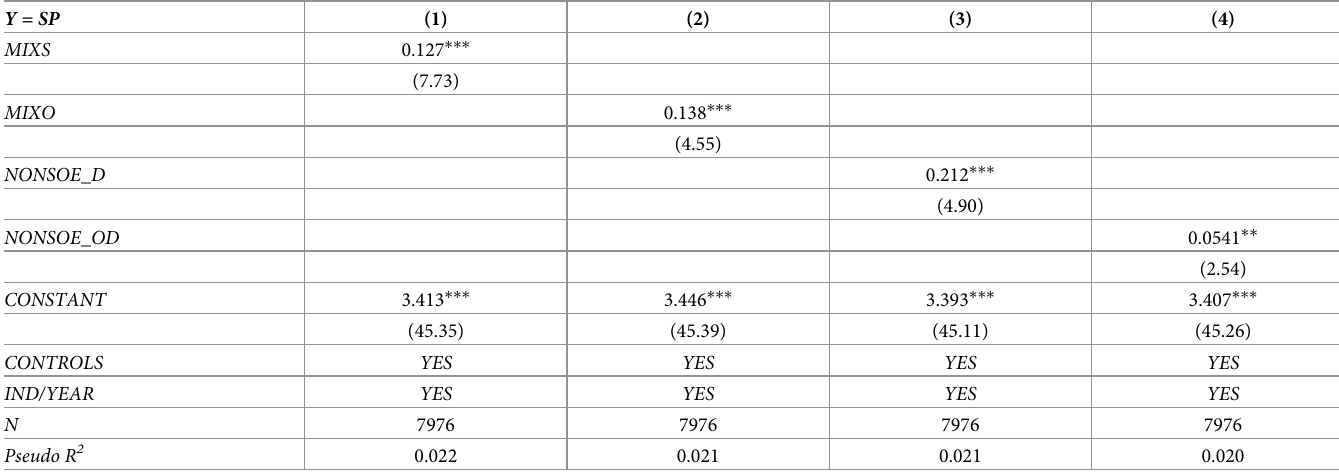
Table 9. Alternative empirical